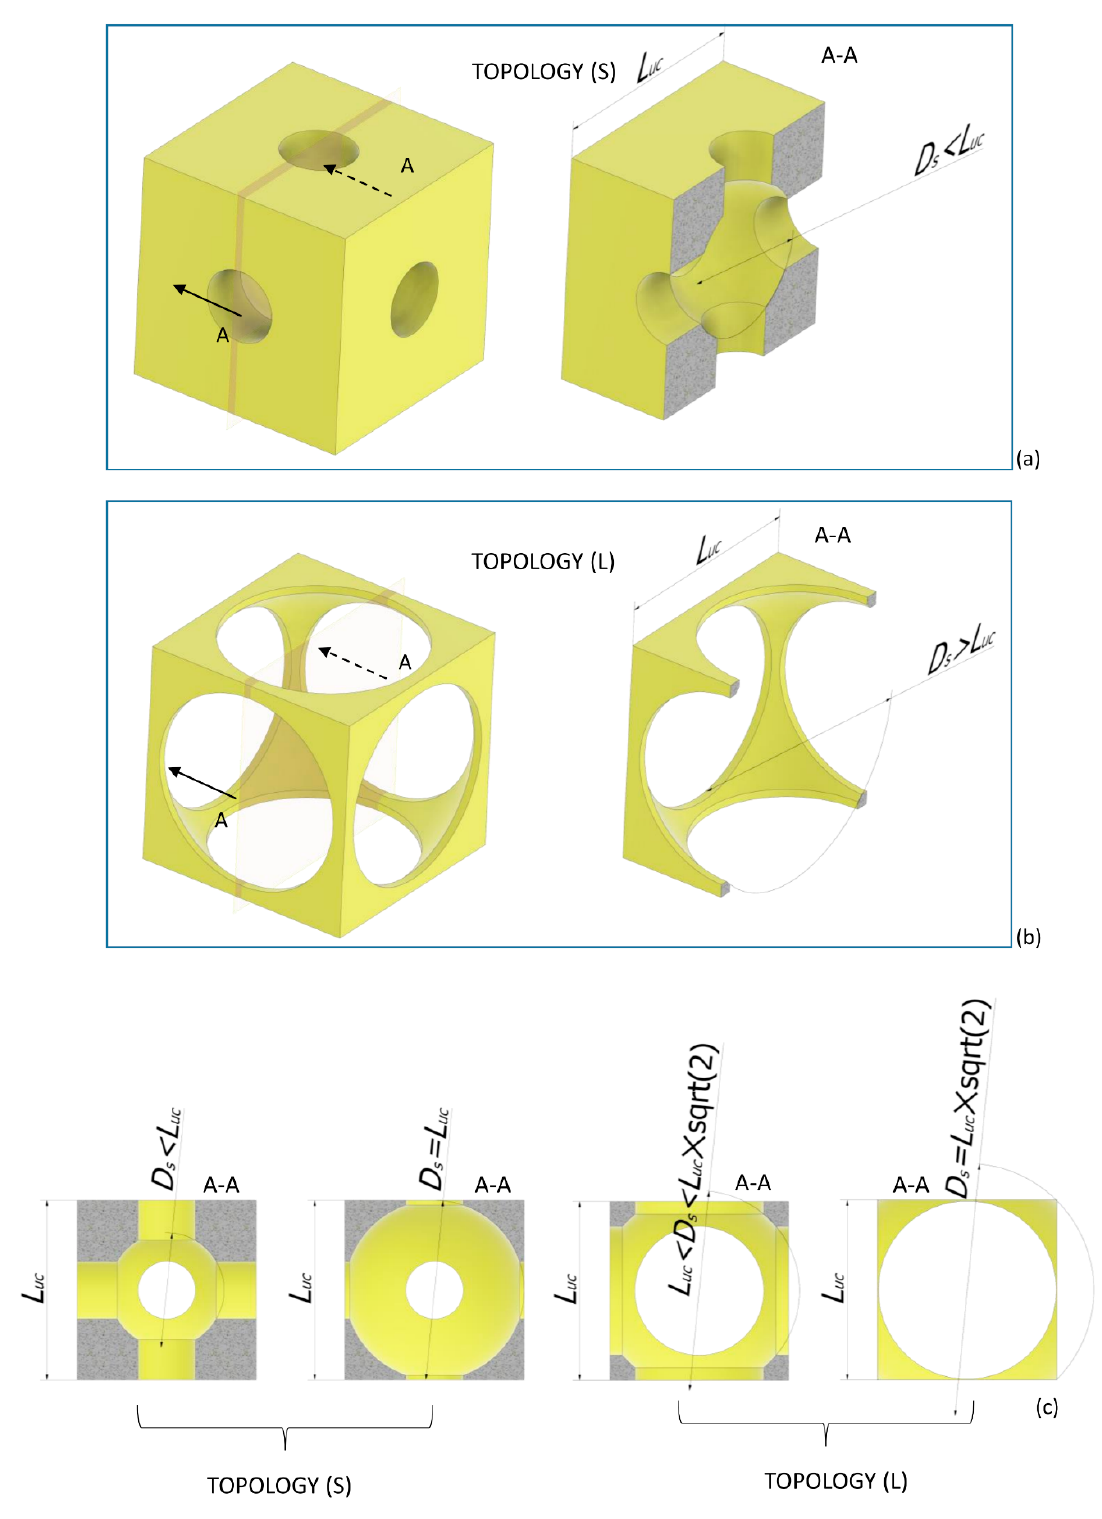
Figure 2. Two different topologies can be built for the scaffold unit cell: “small” (S) ( a ) and “large” (L) ( b ). Topology (S) includes a spherical surface with 0 < D s ≤ L uc ( c ); Topology (L) includes a spherical surface with L uc < D s ≤ √2 × L uc ( c ).